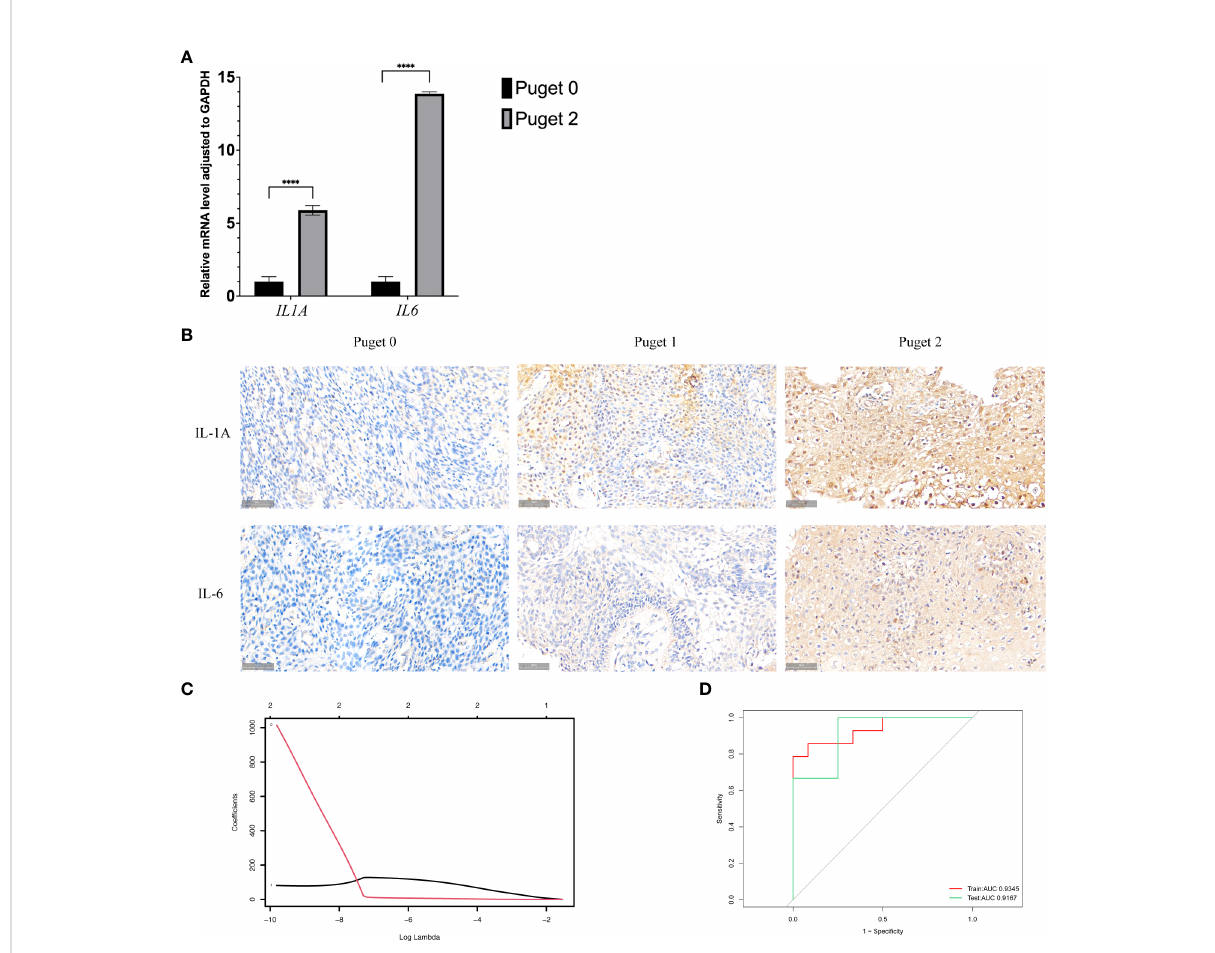
FIGURE 5 Interleukin-1 a ( IL1A ) and interleukin-6 ( IL6 ) in PCP tumors. (A) .Quantitative reverse transcriptase-polymerase chain reaction analysis was performed to analyze the mRNA expression levels of IL1A and IL6 in Puget grade 0 group (n = 16) compared to Puget grade 2 group (n = 20), **** p ≤ 0.0001. (B) . IHC staining of IL-1A and IL-6 in PCP samples of different Puget groups, 40×. (C) . LASSO regression of IL1A and IL6 . (D) . Receiver operating characteristic curve analysis shows the sensitivity and speci fi city for two in fl ammatory factors IL1A and IL6 , as well as the area under the curve with 95% con fi dence